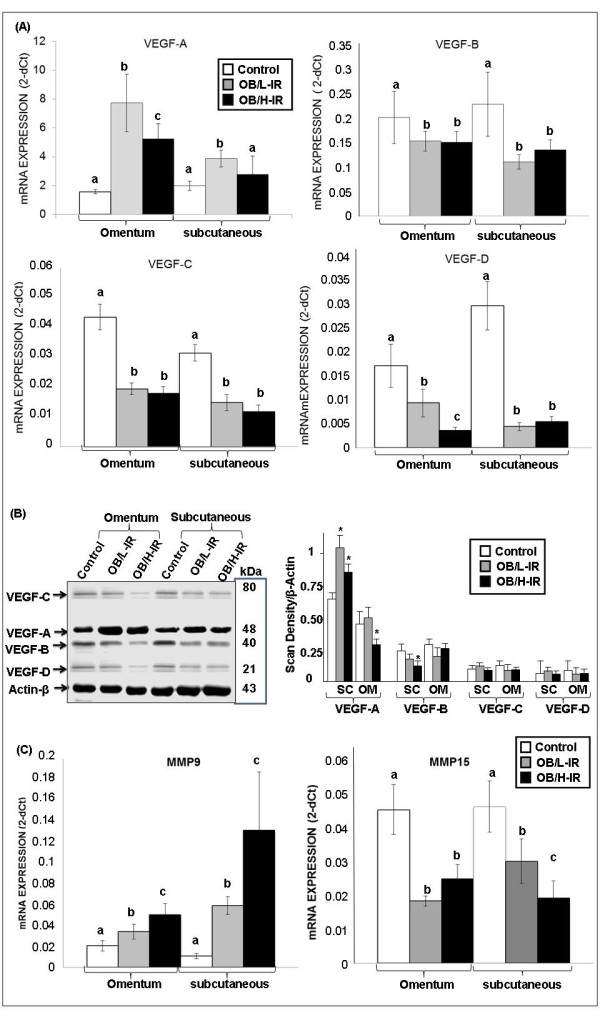
VEGF isoforms, MMP9, MMP15 mRNA and protein expression in omentum and subcutaneous AT from subjects. (A) VEGF isoforms [VEGF-A, VEGF-B, VEGF-C and VEGF-D] mRNA expression analysis was performed on human omentum (OM) and subcutaneous (SC) adipose tissues from three subject groups (lean, OB/H-IR and OB/L-IR subjects). mRNAs were normalized to cyclophilin levels. Results were obtained from triplicate and expressed as the mean ± SEM (n = 17 for controls, n = 12 for OB/L-IR and n = 14 for OB/H-IR). Bars with different letters have a significant difference, p < 0.05. (B) Immunoblotting analysis of VEGF isoforms. The resulted blot of each isoform was compared to Actin-β constitutive protein. Density analyze was done normalizing the samples to β-actin using NIH's Image-J software program. The blot is representative of three independent experiments with different samples, * p < 0.05. (C) Metalloproteinase (MMP9 and MMP15) mRNA expression analysis was performed on human omentum (OM) and subcutaneous (SC) adipose tissues from three groups of subjects (leans, OB/H-IR and OB/L-IR). mRNAs were normalized to cyclophilin levels. Bars with different letters have a significant difference (p < 0.05); differences are compared to the control and between the two groups of obese.